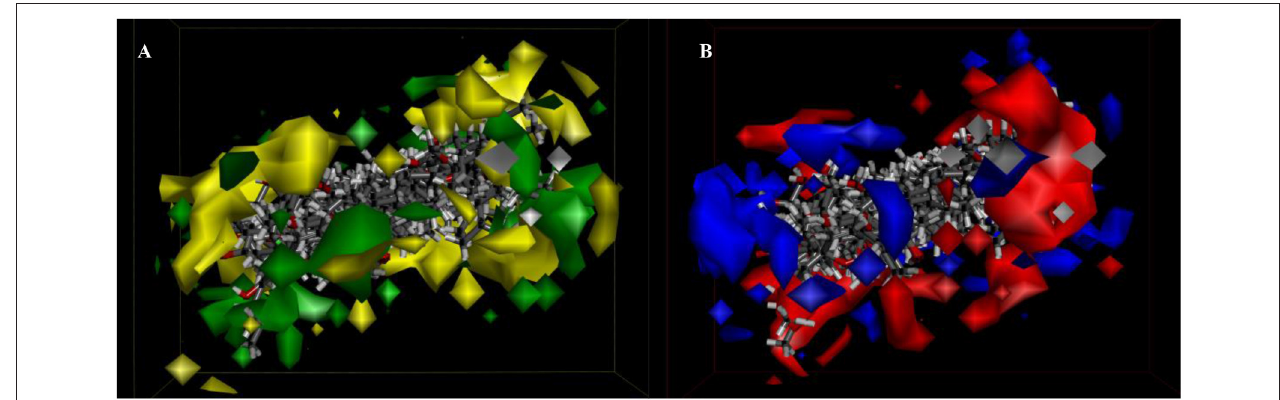
FIGURE 6 | 3D-QSAR model. (A) 3D-QSAR model coefficients of the listed compounds on van der Waals grids. Green represents positive coefficients; yellow represents negative coefficients. (B) 3D-QSAR model coefficients on electrostatic potential grids. Blue represents positive coefficients; red represents negative